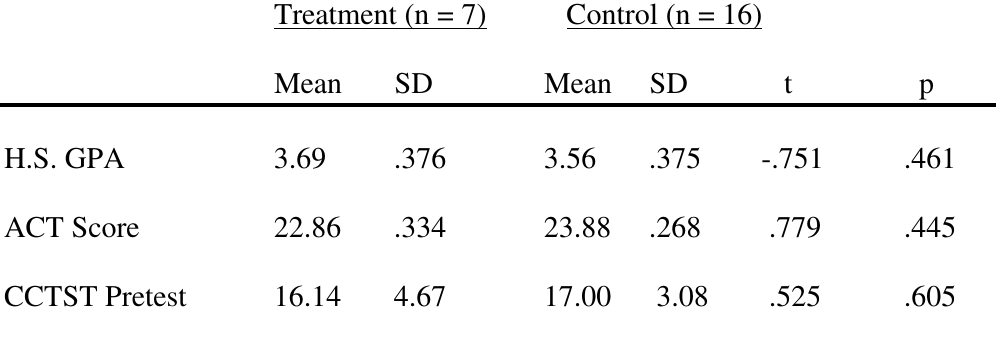
Comparing Means Between Treatment and Control